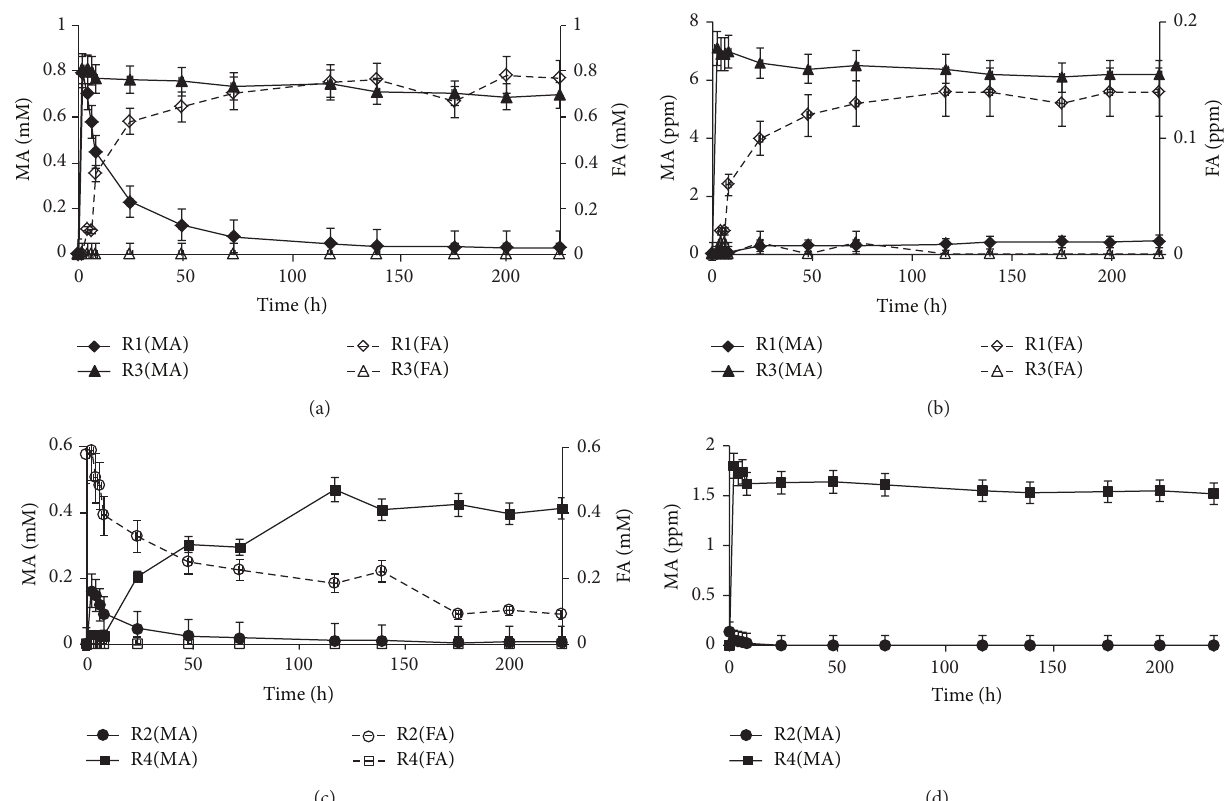
Figure 7: MA and FA concentration in the aqueous ((a) and (c)) and in the gaseous ((b) and (d)) phase of the two-step CFBR system for bioconversion of MA in the 7 mLmin −1 air flow with 10ppm MA inlet concentration by immobilized AMO at the 13.3 U g −1 CA loading (R1) and for oxidation of the produced FA by immobilized AOX at 6.6 U g −1 CA loading (R2). R3 and R4-control reactors connected in series and containing blank beads of CA-gel tested at the same inlet